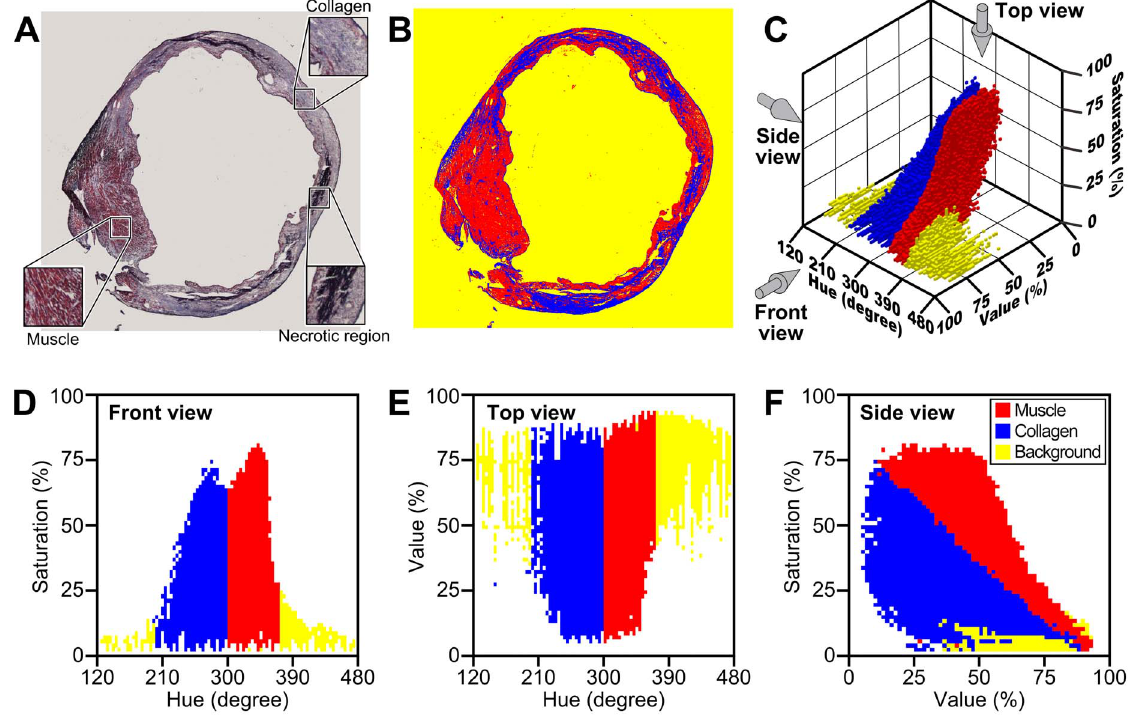
Figure 1. CSH processing on an infarcted mouse heart. A) An infarcted mouse heart section cut 8 m m thick. Muscle tissue is scarlet red, while collagen fibers appear blue, and necrotic regions are purple-black. Insets show enlarged areas of muscle, collagen and necrotic region. B) The same mouse heart, post-processing by CSH . The areas that CSH determined as collagen are blue, and the areas that CSH determined as muscle are red. The background is yellow. C) A plot of the pixels from the original heart image mapped to HSV space. The gray arrows indicate the direction from which this 3-D graph will be displayed in the following 2-D images. D) A plot of the pixels from the original image in the Hue-Saturation plane. The borders collagen and the muscle rectangular thresholds are visible at Hue={200, 300, 385}. E) A plot of the pixels from the original image in the Hue-Value plane. F) A plot of the pixels from the original image in the Value-Saturation plane. This graph most clearly shows the different shapes of the collagen peak (blue) and the muscle peak